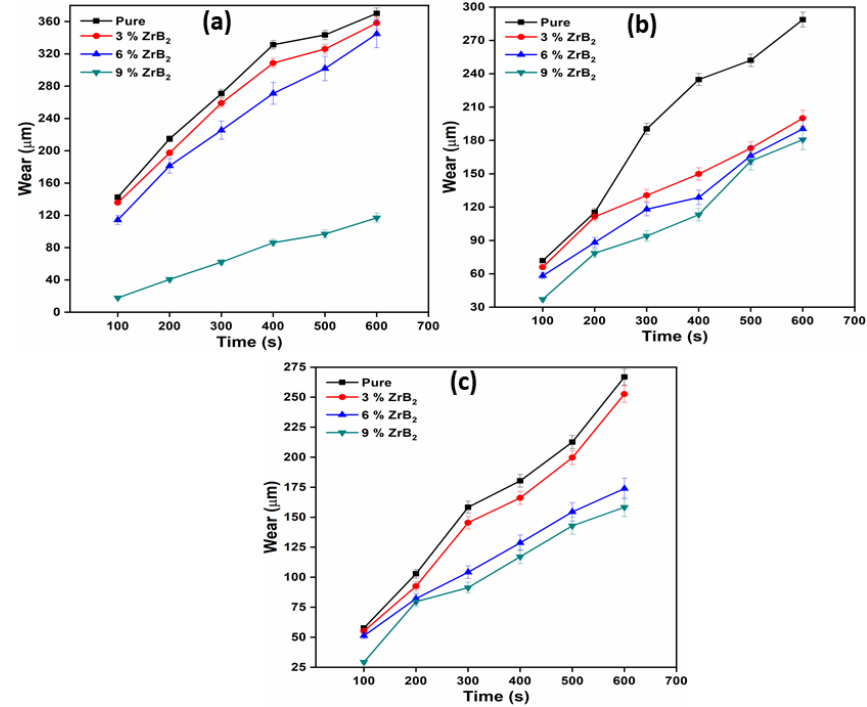
Figure 7. Variation of wear with time at 30 N at ( a ) 600 RPM; ( b ) 400 RPM; ( c ) 200 RPM.